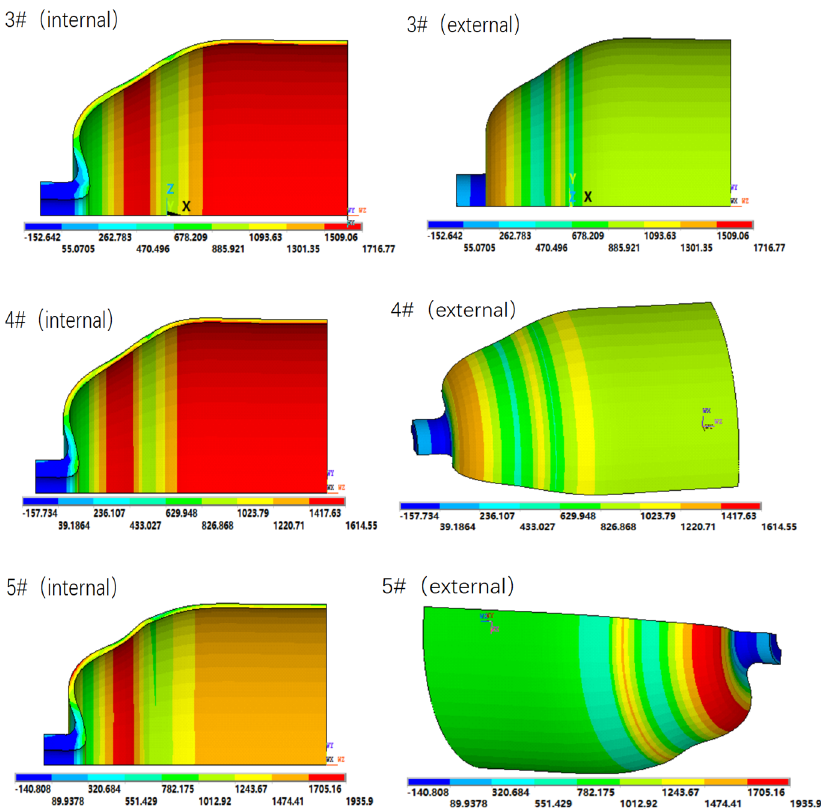
Figure 6. First principal stress nephograms of COPVs 3#–5# (internal pressure: 160 MPa).